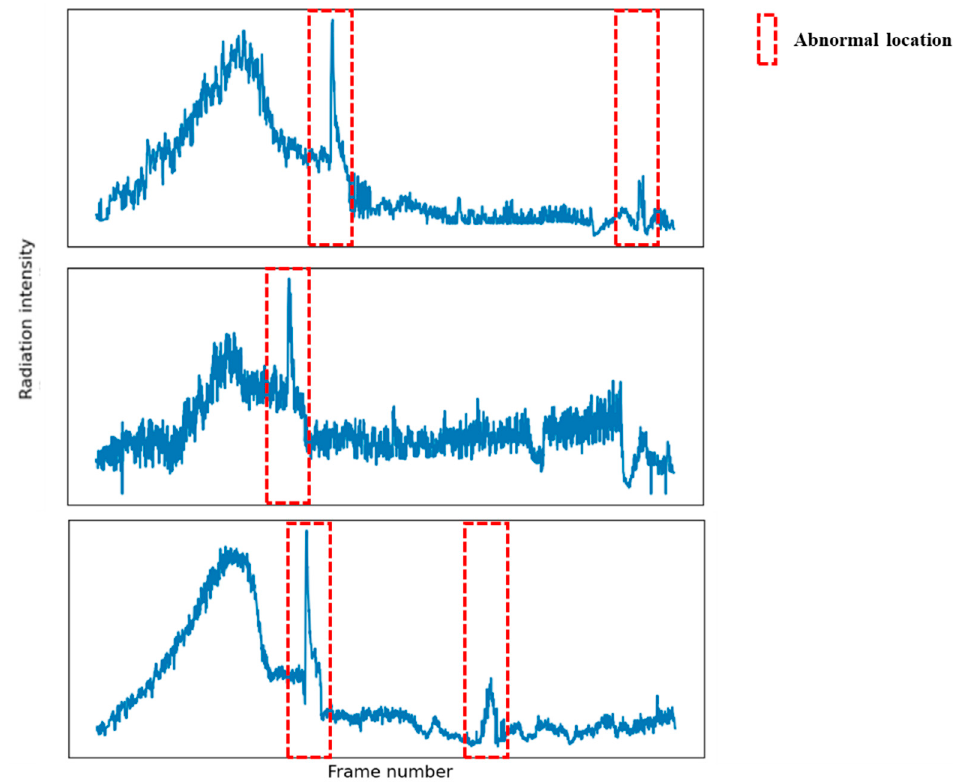
Figure 7. Some data rendering effects of dataset.